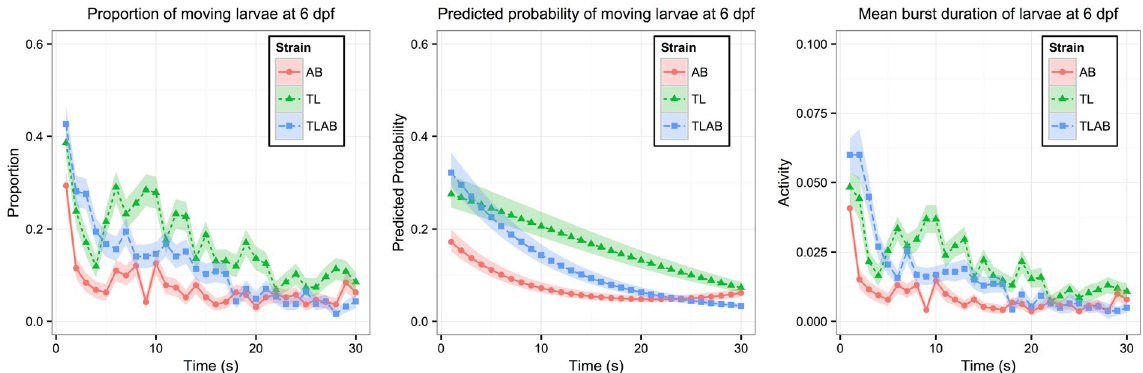
Figure 1. Plots of VMR during the first 30 seconds of Light-On stimulus for WT larvae at 6 dpf. Left panel: Proportions of moving larvae summarized from the data. Y-axis is the proportion of moving larvae and x-axis is time (1–30s). For each strain, the proportions are shown in different colours. The corresponding ribbon represents 1 standard error from the proportion. Middle panel: Predicted probability of moving larvae. Y-axis is the predicted probability of detecting a moving zebrafish larva = ˆ P y ( 1) and x-axis is time (1–30s). The ij predicted probability is shown in a different colour for each strain. The corresponding ribbons represent the lower and upper quartiles. Note that the Y-axes of left and middle panels are the proportion and predicted probability of moving larvae respectively, which can be derived from the LOA, defined as Right panel: Mean Burst Duration of zebrafish larvae during the same time interval. For each strain, its corresponding ribbon represents 1 standard error from the mean activity. These data were used for the Hotelling’s T-squared tests that are reproduced in Table 2. The sample size in this example is 16560 (AB: 5730; TL: 5280; TLAB: 5550).